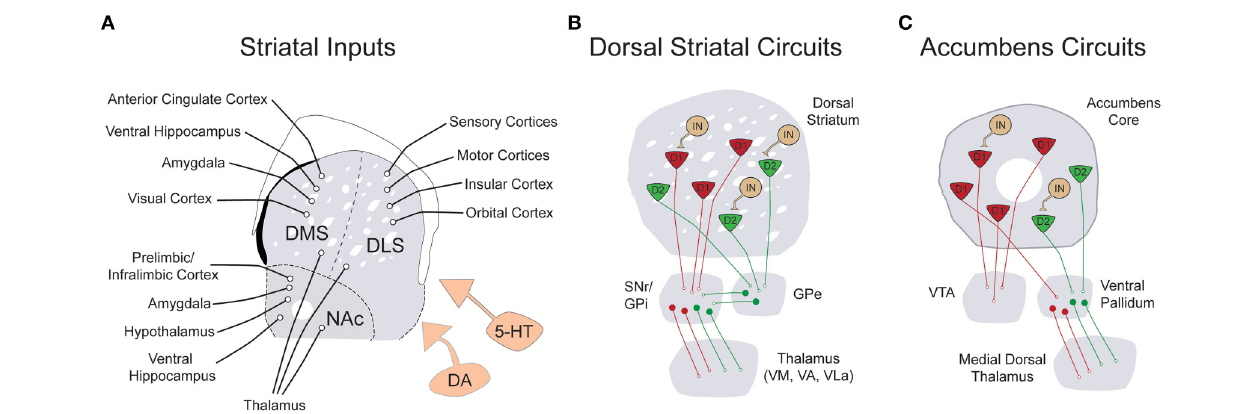
FIGURE 1 | Simplified schematic of the input and local connectivity of the mammalian basal ganglia. (A) Diagram of known excitatory inputs to distinct striatal sub-regions including dorsomedial striatum (DMS), dorsolateral striatum (DLS), and nucleus accumbens (NAc). All striatal sub-regions are under dopaminergic and serotonergic neuromodulatory control (orange). (B) Diagram of major dorsal striatal cell types and their downstream connectivity within basal ganglia circuits. In contrast to striatal inputs, nearly all cell types within the basal ganglia are inhibitory. The striatum is comprised of D1R+ (red) and D2R + (green) medium spiny neurons (MSNs), as well as a smaller population of local circuit interneurons (tan). The direct pathway projection of D1R + MSNs is diagrammed in red and the indirect pathway projection of D2R+ MSNs is drawn in green. (C) Diagram of the major cell types and connectivity of the nucleus accumbens core. Note that in contrast to the strict divergence of D1R + and D2R+ MSNs in the dorsal striatum, D1R + MSNs of the nucleus accumbens project both to the ventral tegmental area and the ventral